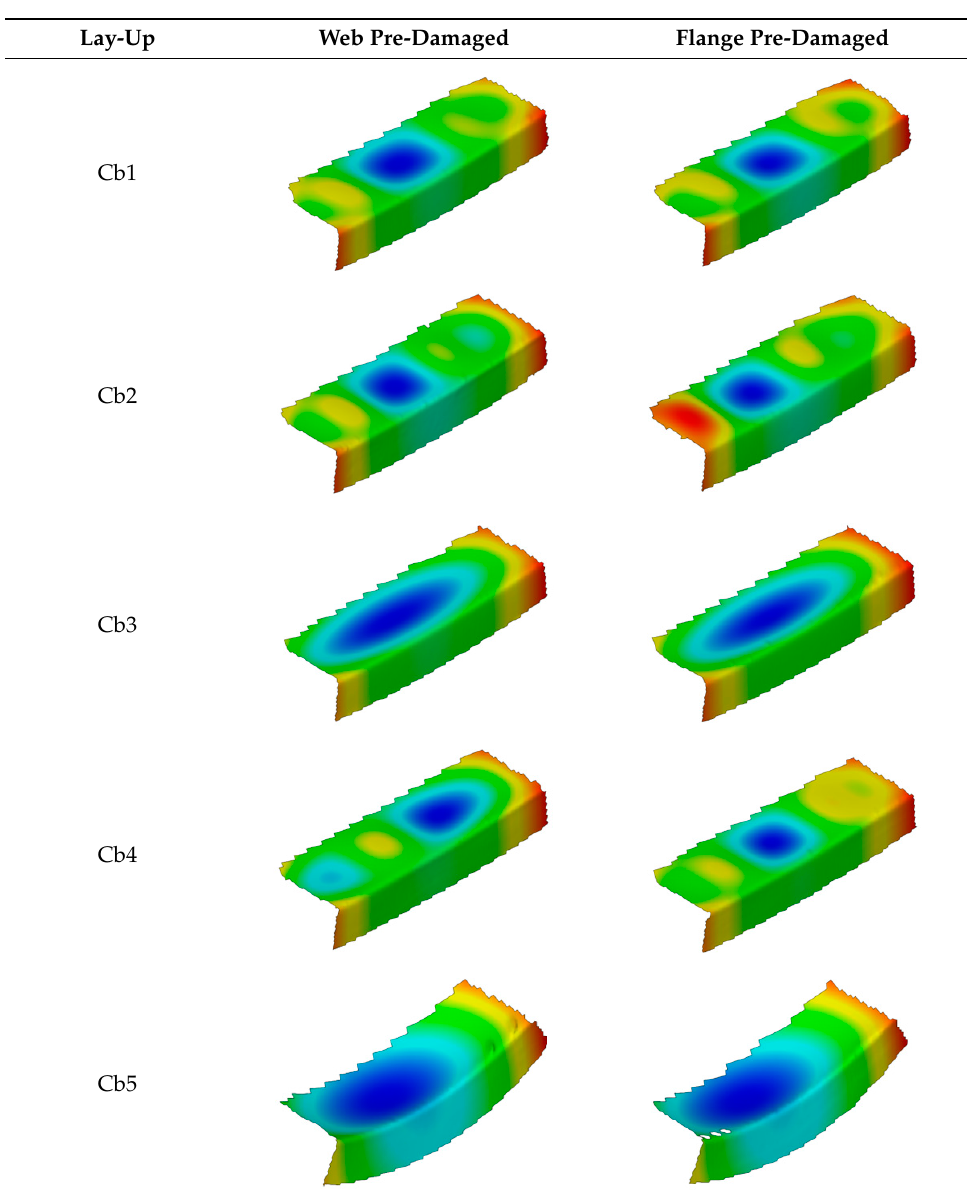
Table 4. Deflection corresponding to buckling mode.